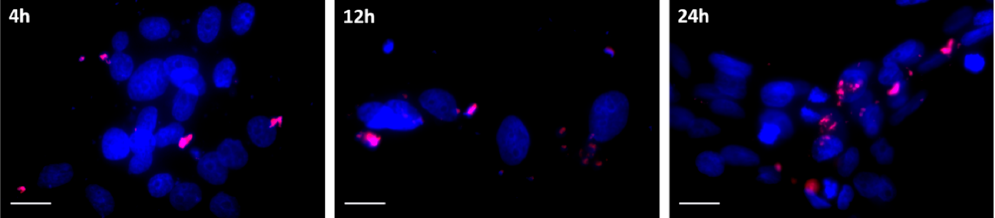
Figure 6. The uptake of the vector III in HCE-2 cells 2 h after transfection with Nile Red-labelled vector containing p-shRNA-MMP-9 against MMP-9. ( A ) Fluorescence microscopy image (40 × ); ( B ) flow cytometry histograms.